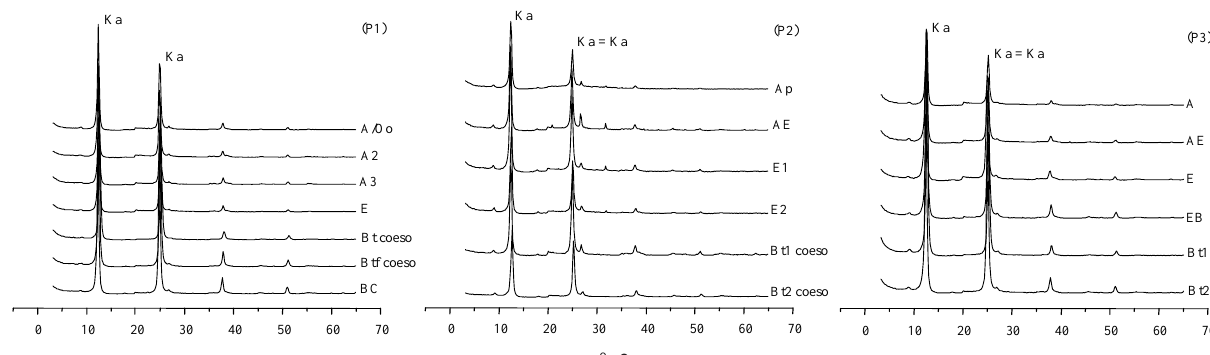
Figura 1. Difratograma de raios-X da fração argila de três perfis de solo derivados da Formação Barreiras no estado do Ceará (Ka –